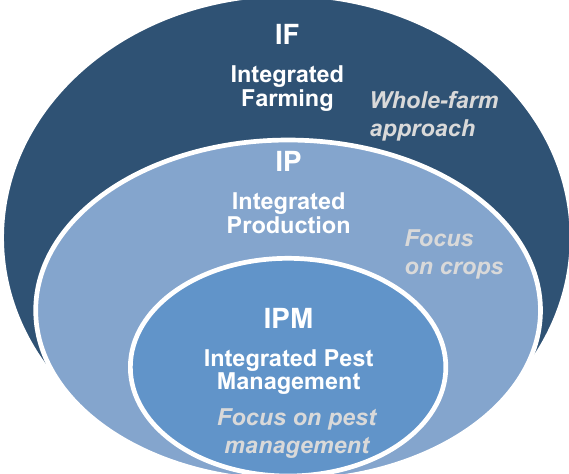
Figure 1. Integrated Pest Management (IPM) focuses on pest, disease, and weed management; IPM is part of Inte - grated Crop Management, which addresses all crop culti - vation problems (including soil management, fertilization, irrigation), and of Integrated Farm Management, which fo - cuses on the entire farm management cycle (including ani - mal welfare, energy procurement, landscape